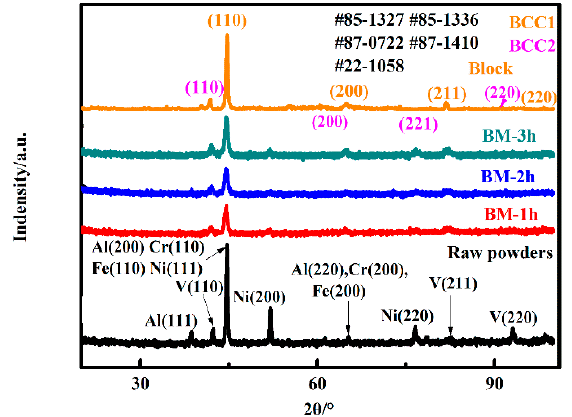
Figure 3. XRD patterns of the AlCrFeNiV block and powders with different ball milling times.